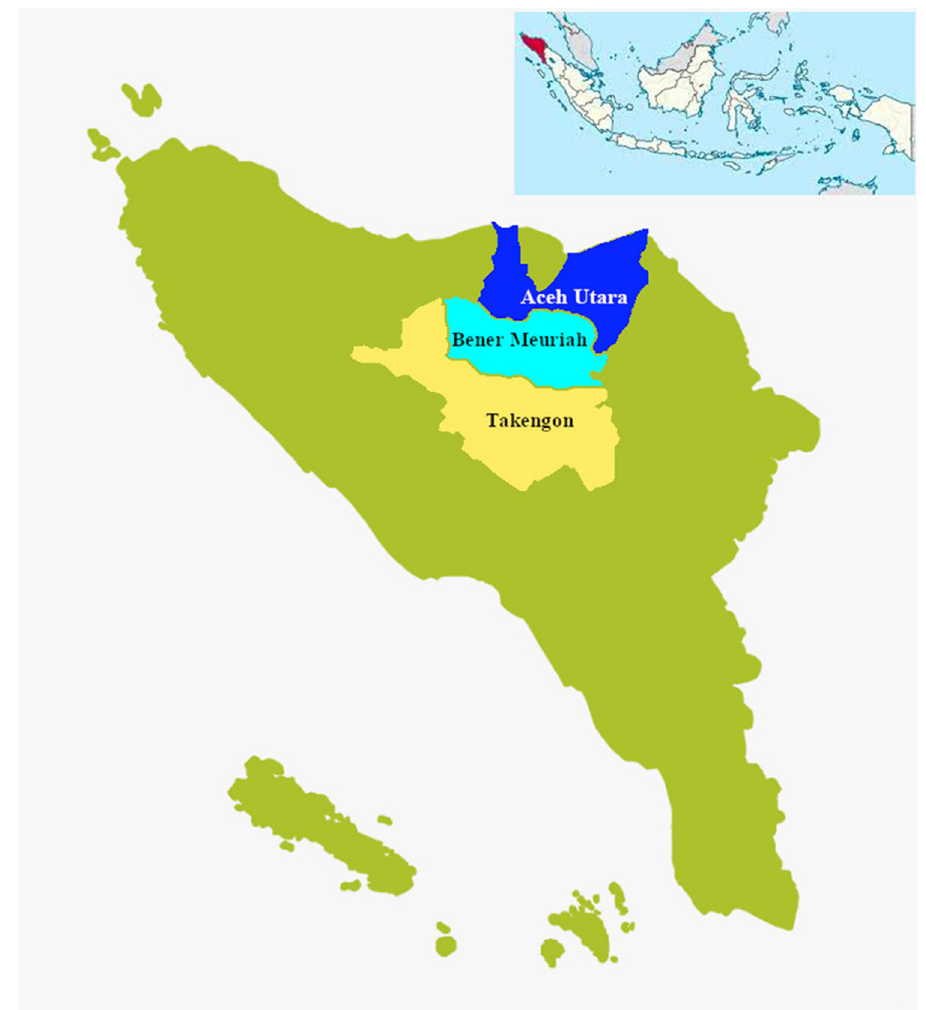
Figure 2: Map of Indonesia, Aceh Utara, Bener Meriah, and Takengon